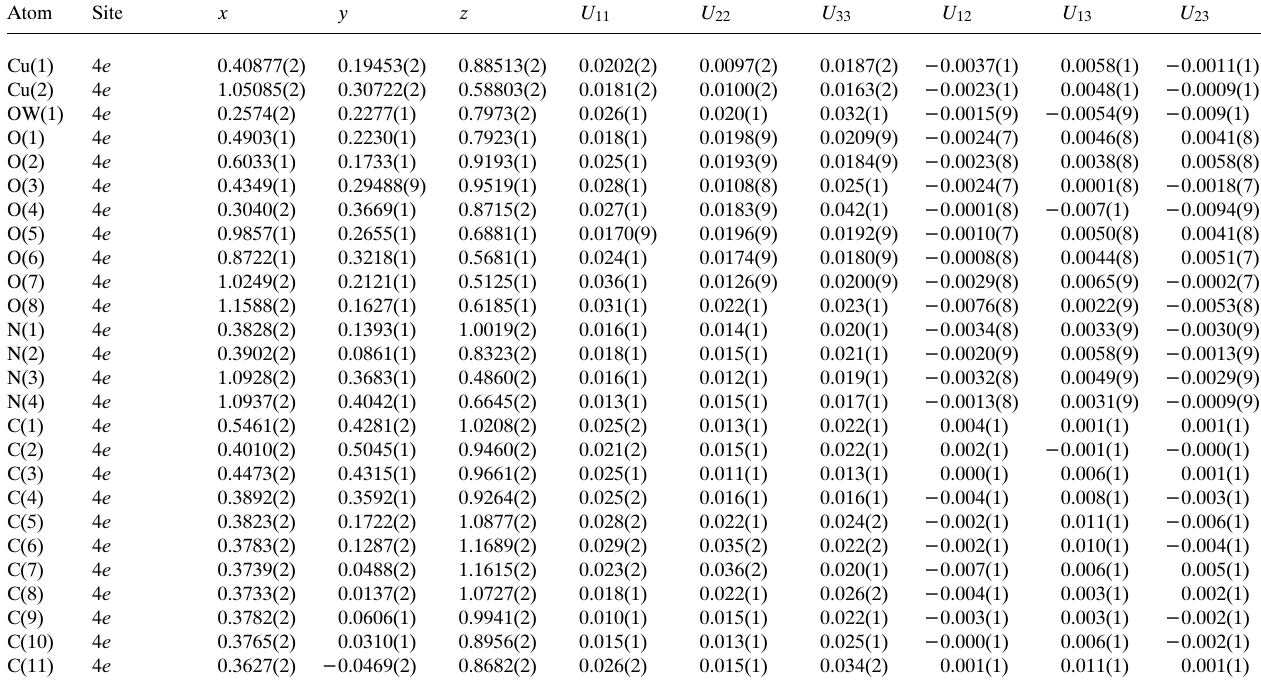
Table 3. Atomic coordinates and displacement parameters (in Å 2 ) .